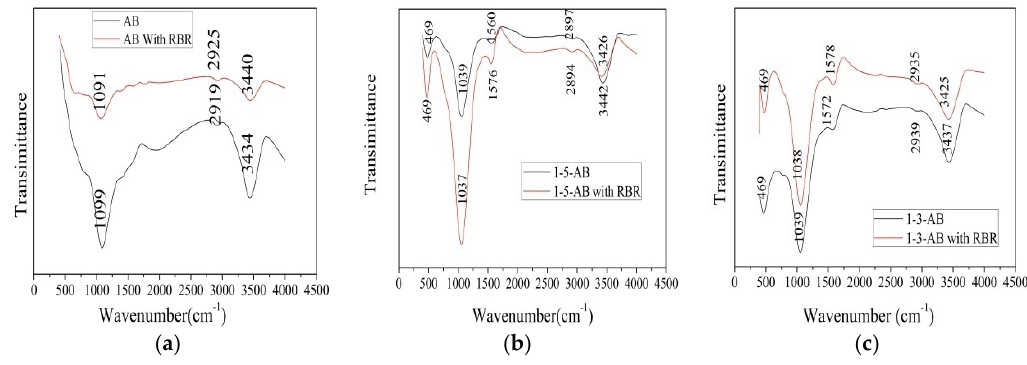
Figure 9. FTIR spectra of the biochar samples before and after the adsorption of RBR: ( a ) AB before and after the adsorption of RBR, ( b ) 1-5-AB before and after the adsorption of RBR, and ( c ) 1-3-AB before and after the adsorption of RBR.